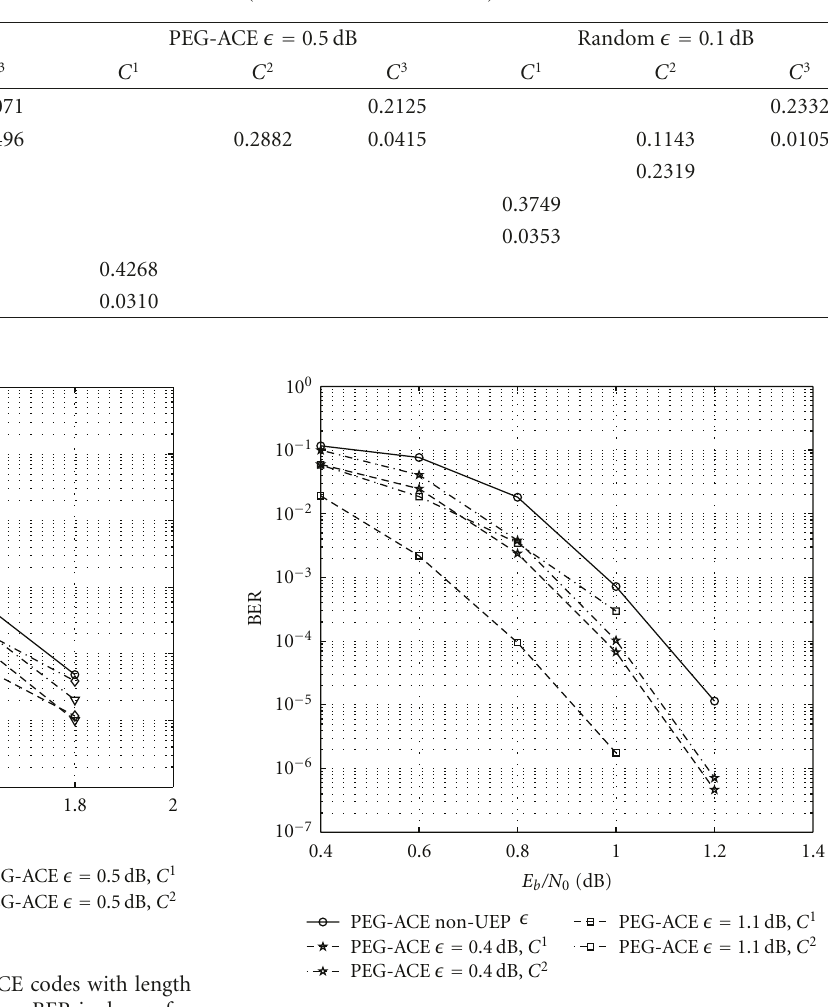
Figure 3: BER performance of non-UEP and UEP codes of length n = 8192 and d v max = 30. Both classes of the two UEP codes have lower BER than the non-UEP code. The code optimized for a low /N E (cid:2) = 1 . 1 dB performs best at low E b /N b 0 (0.5dB) with the code optimized for high E b /N 0 (1dB) with (cid:2) = 0 . 4 dB has a lower average BER at E b /N 0 above